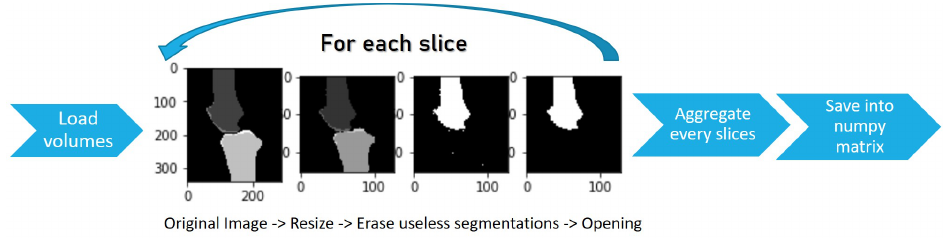
Figure 9. Segmentation pre-processing pipeline.